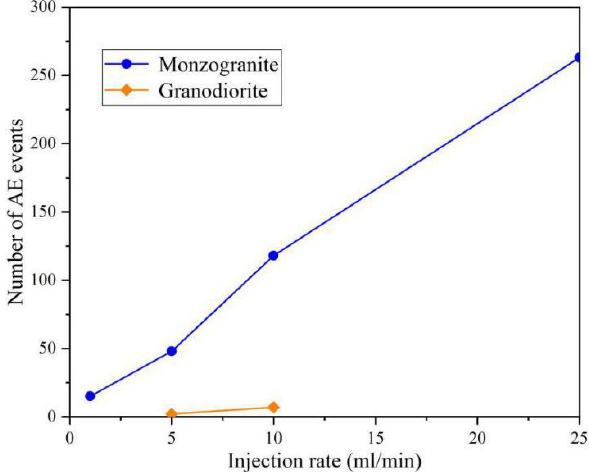
Figure 12. Number of AE events at different injection rates in room-temperature fracturing tests.